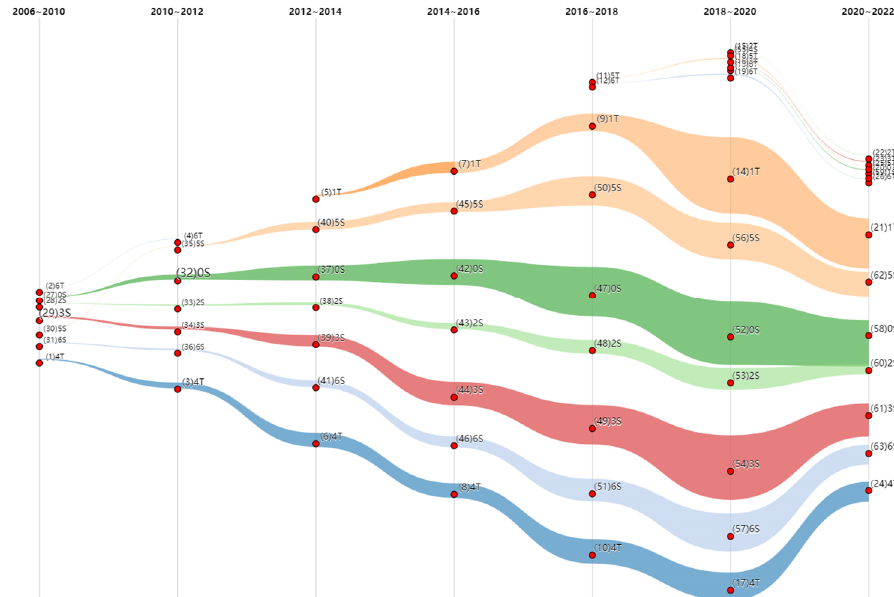
Figure 2. Multi-source theme river map.